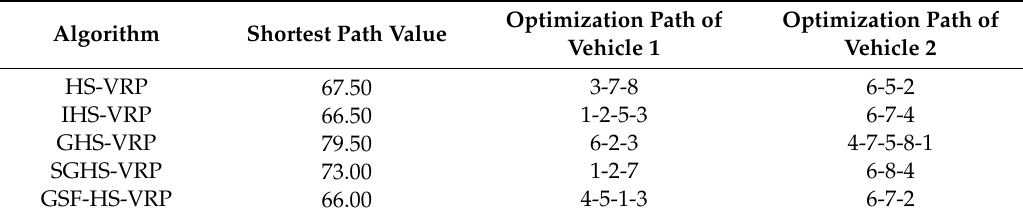
Figure 2. Average optimum of each algorithm . Table 3. Comparison of vehicle routing optimization for each algorithm .